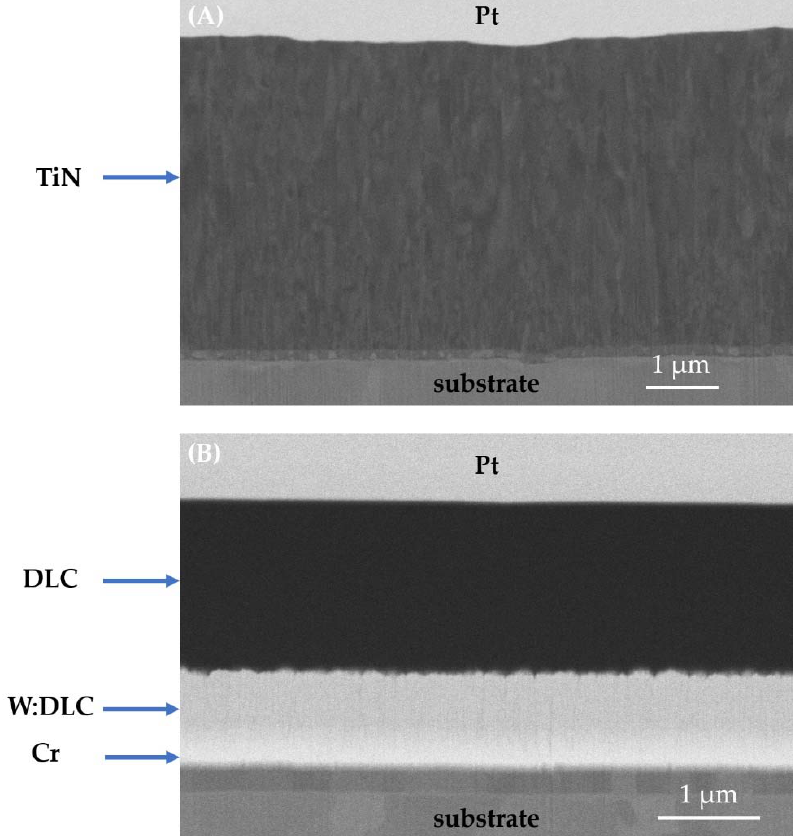
Figure 1. FIB-SEM cross sections of: ( A ) titanium nitride, ( B ) hybrid DLC coating. Pt is a protective layer deposited in situ during preparation of a cross section.